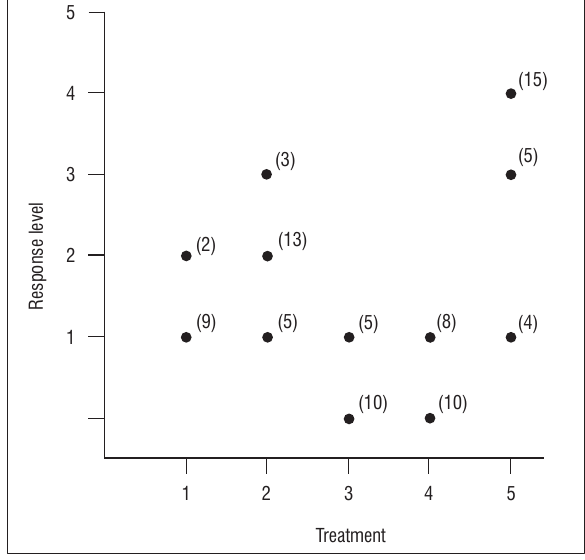
elephants to each of the five treatments ( F =52.15, d.f.=4, p <0.001,